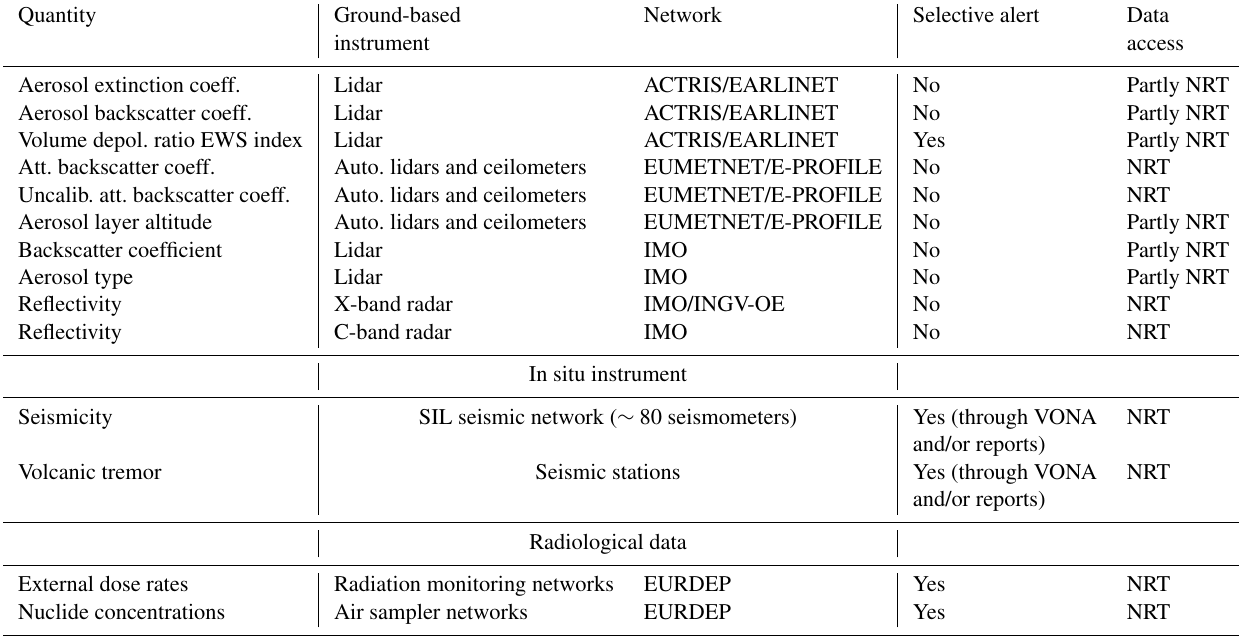
Table 3. Inventory of NRT ground-based and in situ products. ACTRIS: Aerosol, Clouds and Trace Gases Research Infrastructure. EAR- LINET: European Aerosol Research Lidar Network. IMO: Icelandic Meteorological Office. INGV-OE: Italian National Institute of Geo- physics and Volcanology Etna Observatory. SIL: South Iceland Lowland.